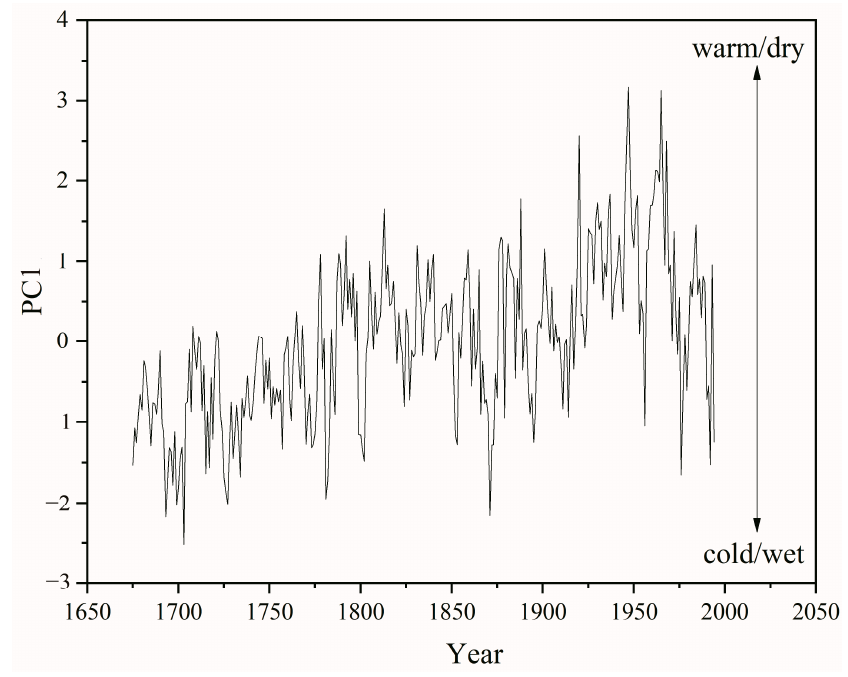
Figure 4. Time series of the first principal component extracted from the four paleoclimate proxies.